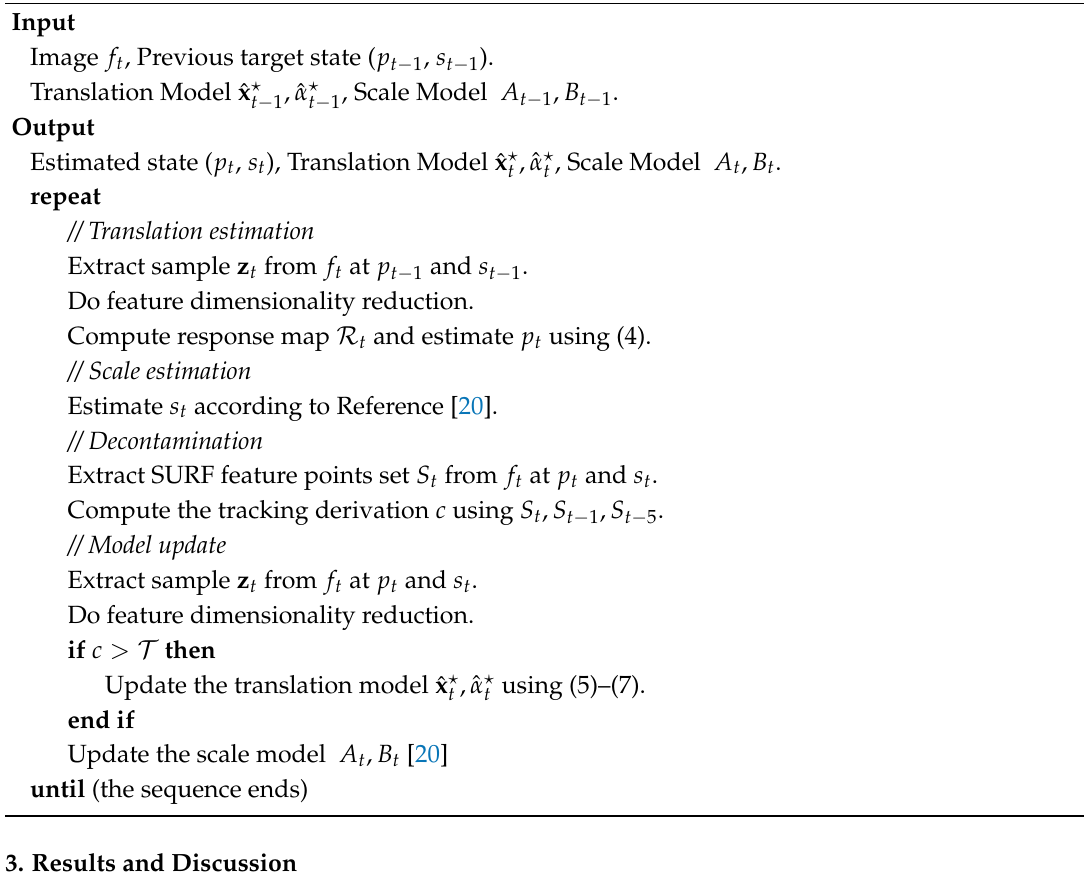
Algorithm 1 Proposed tracking